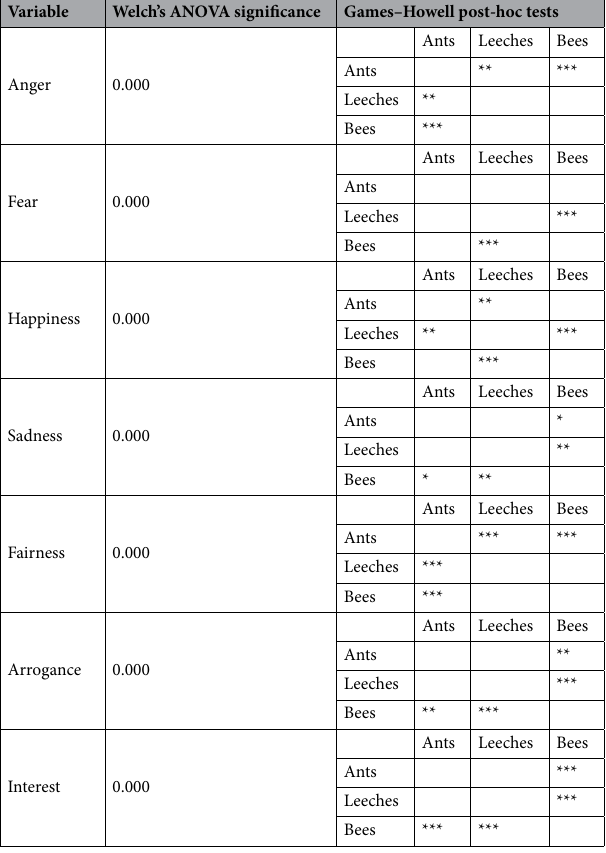
Table 4. Welch’s ANOVA—Healthcare Innovation dataset. ^p < 0.1; *p < 0.05; **p < 0.01; ***p < 0.001.